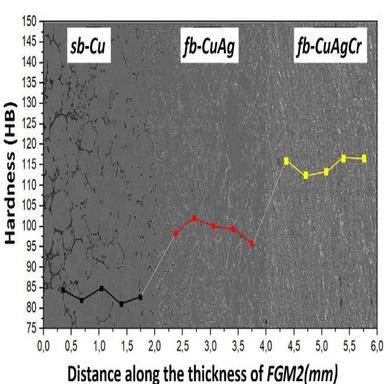
Oxidation resistance of layers of FGMs.